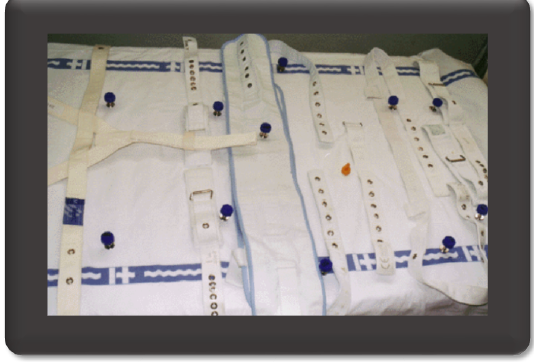
Figure 1. Typical mechanical contention (MC) equipment, based on different